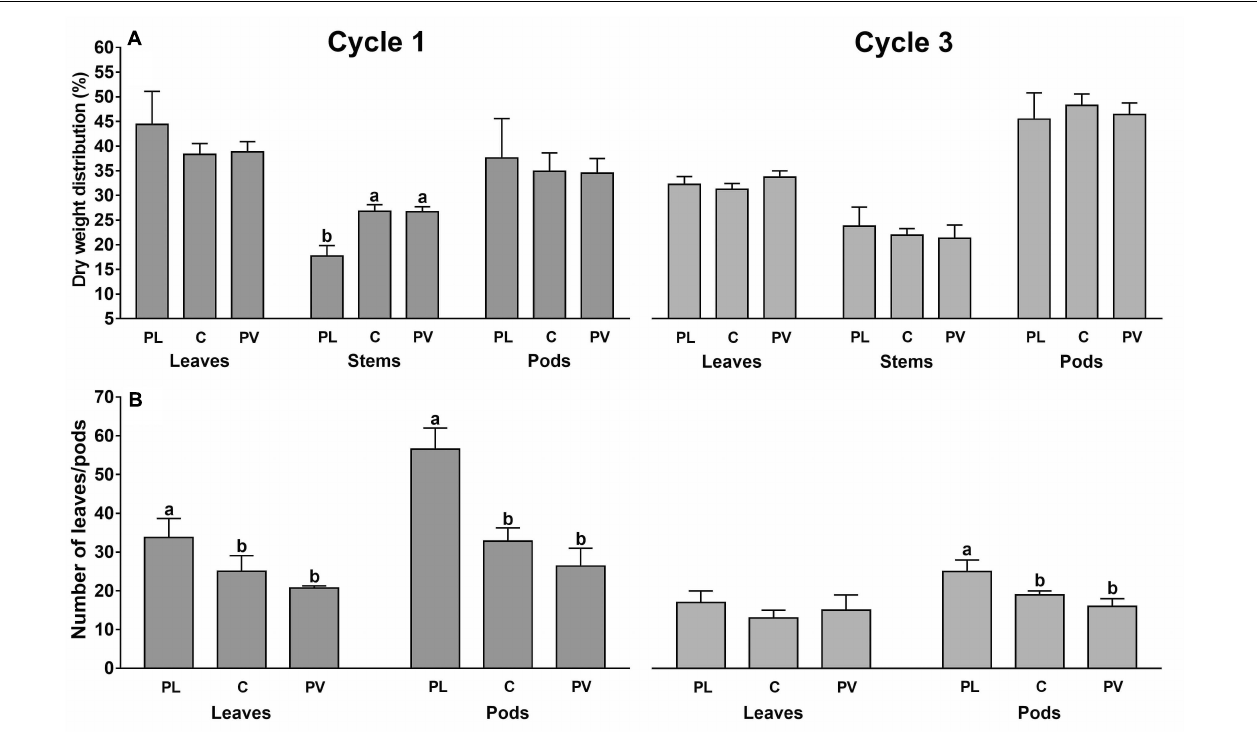
FIGURE 6 | Percentage dry weight distribution in the plant organs (A) and average number of leaves and pods per plant (B) under the plastic roof (rows 2, PL), center of the greenhouse span (rows 4, C) and photovoltaic roof (rows 6, PV). Data are referred to cycle 1 and 3 (cycle 2 data not retrieved). Each bar is the average of eight sample plants (two for each experimental area). The upper bars represent the standard deviation. Bars that do not share a letter are significantly different (LSD test p < 0.05).